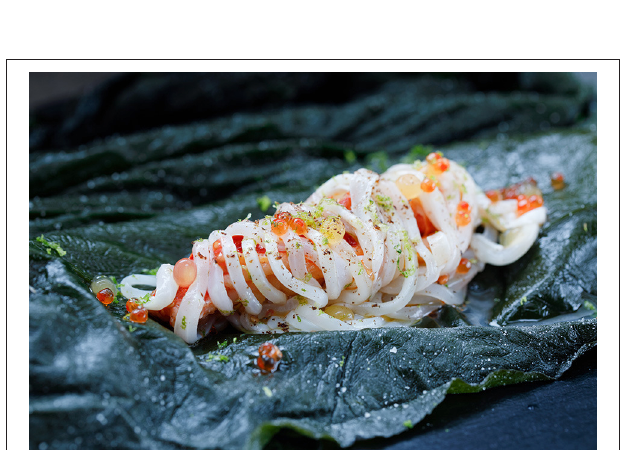
FIGURE 5 | Squid “fettucine:” a novel dish made with squid ( Loligo forbesii ), lobster, cherry tomatoes, lime juice, ponzu , salmon roe, lemon spheres, and black dried lime. Photo: permission by and courtesy of Jonas Drotner Mouritsen.